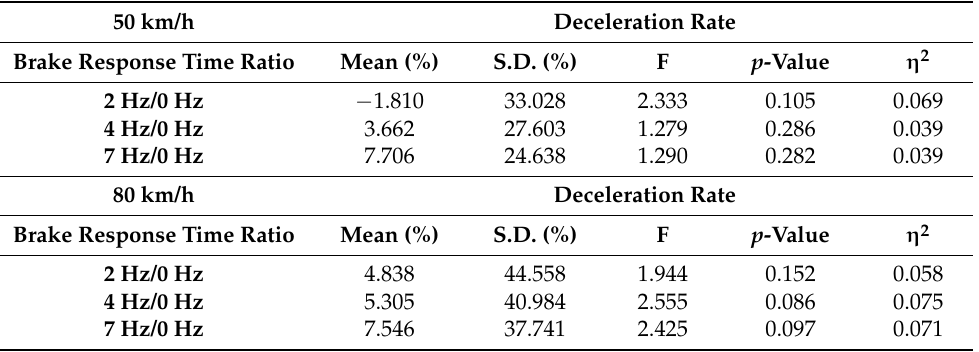
Table 2. ANOVA results for the braking response time ratio in the two driving environments considering the deceleration